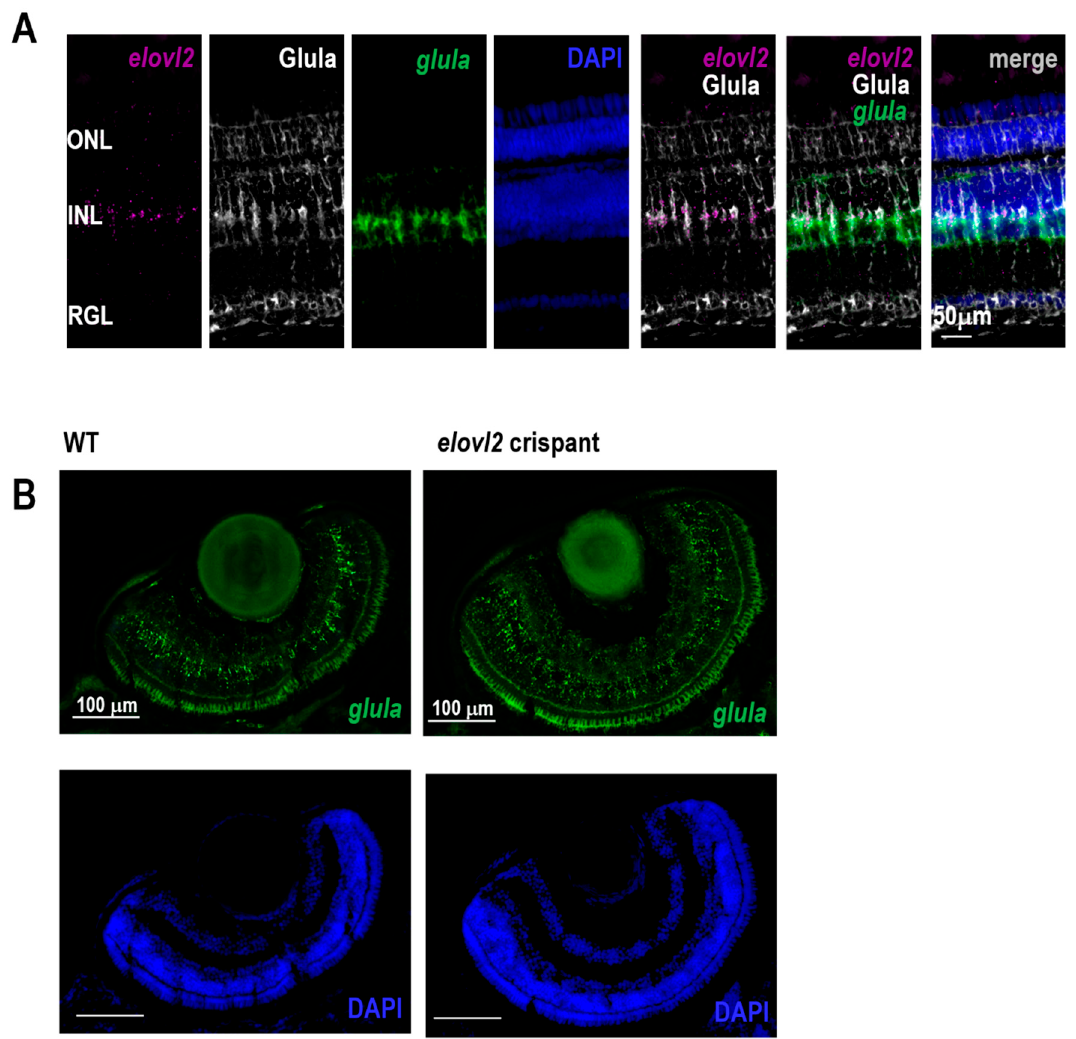
Figure 4. ( A ) Expression of elovl2 RNA and Muller Glia specific gene glula as detected by RNAscope and Glula immunohistochemistry in normal adult zebrafish. ( B ) Expression of glula in 7dpf control and elovl2 crispants shows no changes of glula expression upon elovl2 knockout.